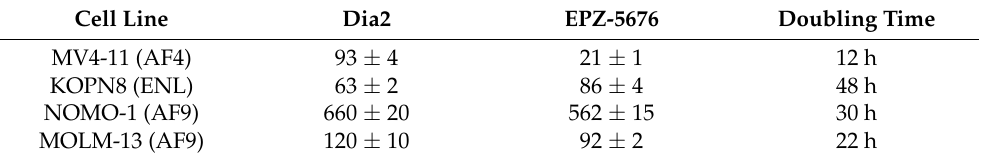
Figure 5. MLL-AF9 cells: MOLM13 and NOMO-1. ( A ) Right, growth of MOML-13 (MLL-AF9) cells up to 15 days of incubation with 3.2 µ M (red circles), 1 µ M (orange circles), 0.32 µ M (pink circles) of Dia2 , and 3.2 µ M (cyan triangles), 1 µ M (sky blue triangles), 0.32 µ M (violet triangles) of EPZ-5676 compared to DMSO treated cells (black squares) were plotted as the ratio amount of cells over initial population. Left, viable cells were counted every 3 to 4 days in the presence of Dia2 , EPZ-5676, or DMSO, and the percentage of viability is reported as dotted curves. Every data point is the result of technical triplicates ( B ) Right, growth of NOMO-1 cells (MLL-AF9) up to 22 days of incubation with 10 µ M (bordeaux red circles), 3.2 µ M (red circles), 1 µ M (orange circles) of Dia2 , and 10 µ M (dark blue triangles), 3.2 µ M (cyan triangles), 1 µ M (sky blue triangles) of EPZ-5676 compared to DMSO-treated cells (black squares) were plotted as the ratio amount of cells over initial population. Left, viable cells were counted every 3 to 4 days in the presence of Dia2 , EPZ-5676, or DMSO, and the percentage of viability is reported as dotted curves. Every data point is the result of biological duplicates. Table 1. The mean value of EC 50 (nM) of the proliferation inhibition for selected MLLr cell lines after 15-day treatment (mean value of two independent experiments run in triplicate and standard